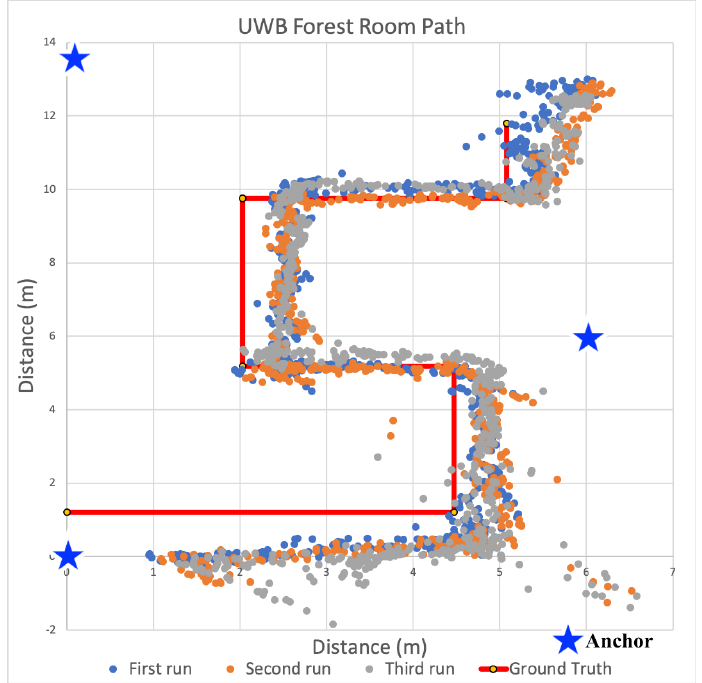
Figure 17. Position estimates obtained using two-way ranging localization with Ultra Wide Band in the mixed use space called the Forrest Room. Reference anchor locations used for localization are shown as stars and the solid red line constitutes the ground truth path. The different colored points show the calculated positions while traversing the Forrest Room space during multiple successive experiments.